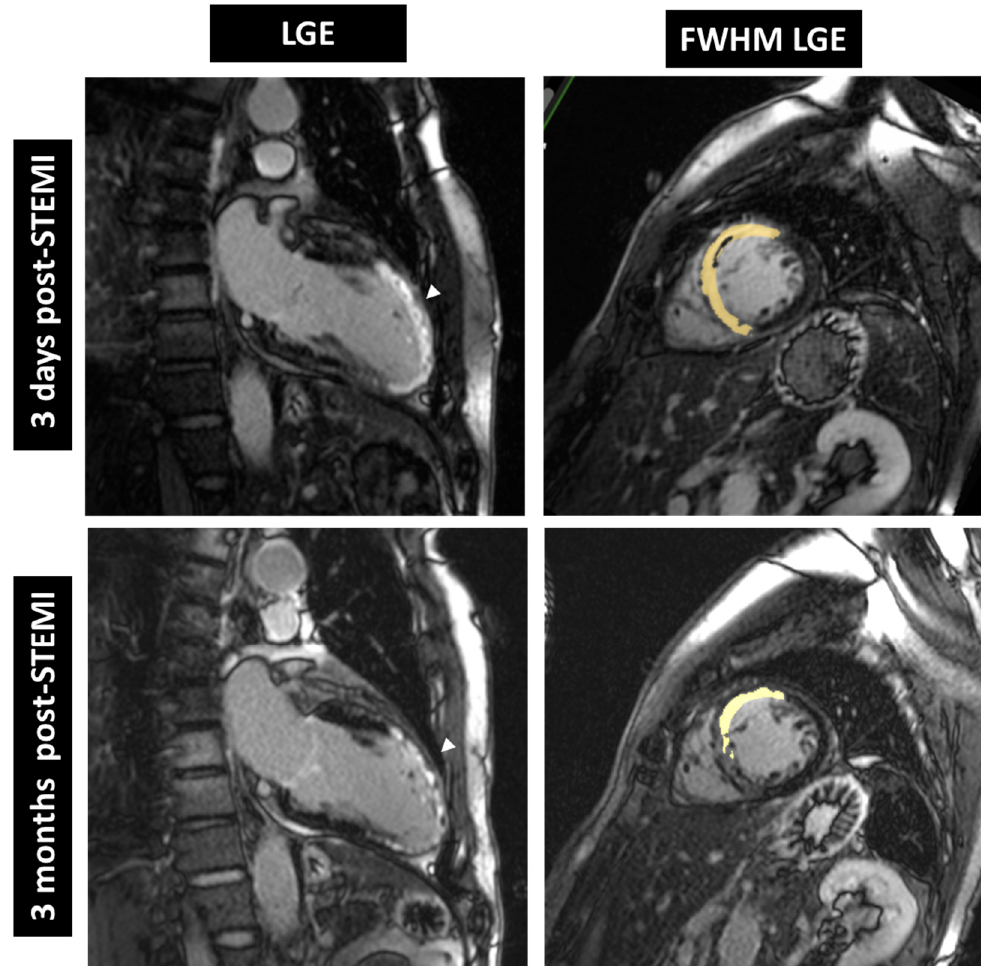
Figure 3. Cardiac magnetic resonance images from a patient receiving dutogliptin + filgrastim. LGE (left) and FWHM LGE (right) were reduced 3 months post-STEMI compared to baseline (3 days post-STEMI). LGE = late gadolinium enhancement, FWHM = full-width at half-maximum, arrow = LGE. Table 5. Summary of Tissue Characterization Parameters from Day 3 to Day 90 (ITT and PP Popu- lations).